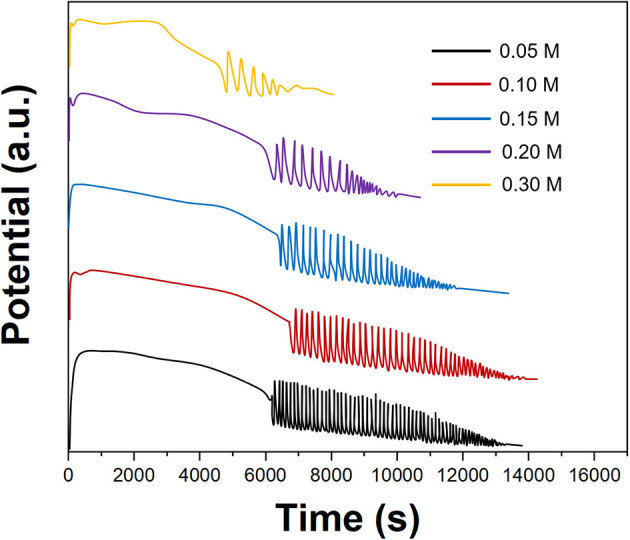
Oscillating profiles of Prunus persica recorded using different concentrations of MnSO4.